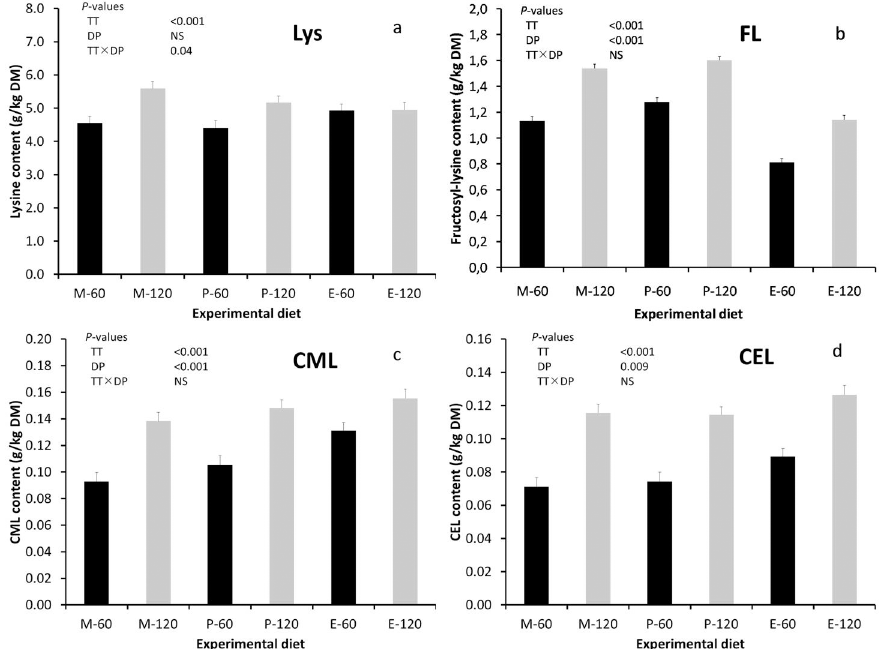
Fig 1. Contents (g/kg DM) of (a) total lysine, (b) fructosyl-lysine, (c) carboxymethyl-lysine (CML) and (d) carboxyethyl-lysine (CEL) in the ileal chyme of RSM diets toasted for 60 or 120 min and either fed as mash, pelleted or extruded. Means plus standard errors. Abbreviations: TT, toasting time; DP, diet processing; NS, not significant. Fructosyl-lysine (g/kg DM) = furosine (g/kg DM) × 3.3; based on Krause et al.